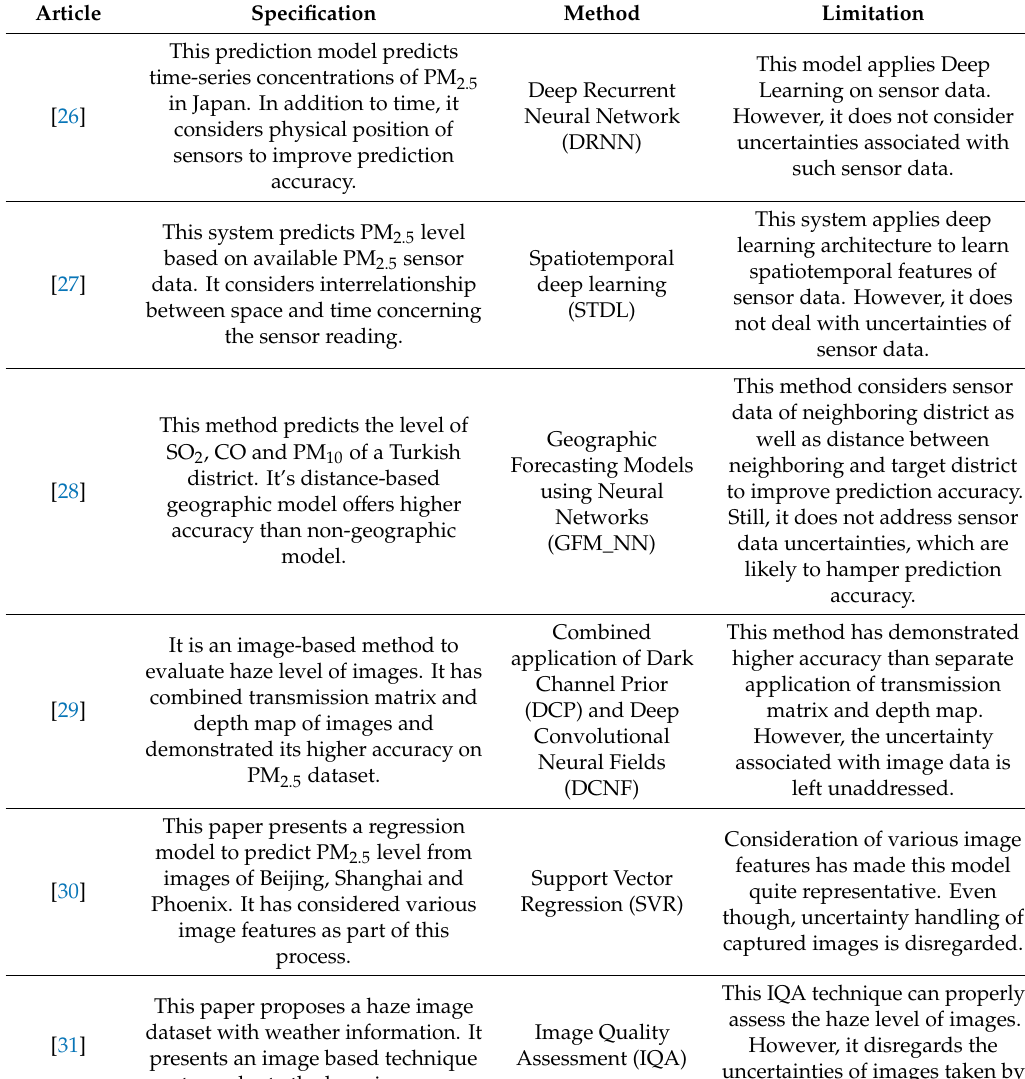
Table 1. Taxonomy of related